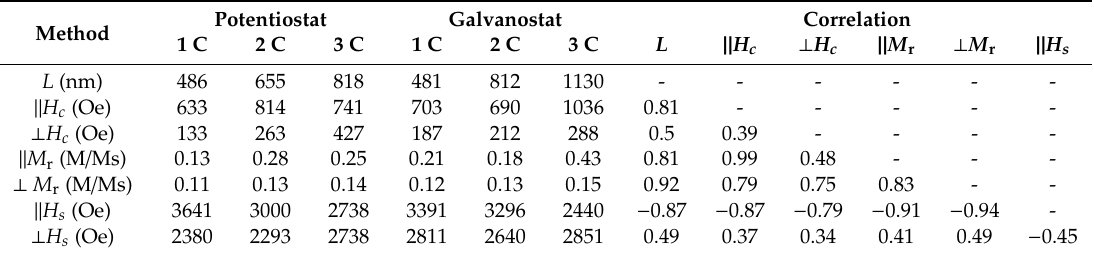
Table 1. Parallel and perpendicular magnetic properties of Ni-Npillars and their correlation variables. The blanks are either one between the same variable, or the same value with respect to its symmetry. Method